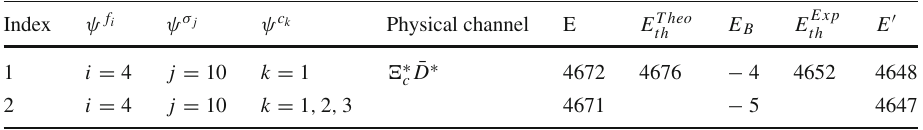
Table 5 The results for I J P = 0 5 2